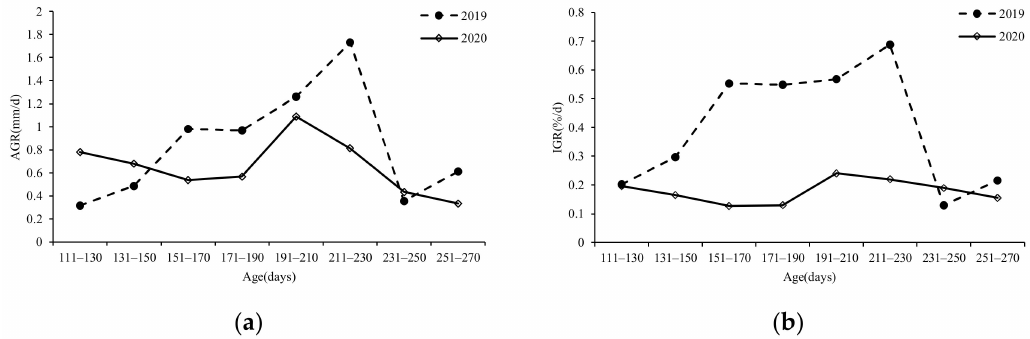
Figure 11. Relationship between ML growth rate and age of S. oualaniensis : ( a ) AGR; ( b )